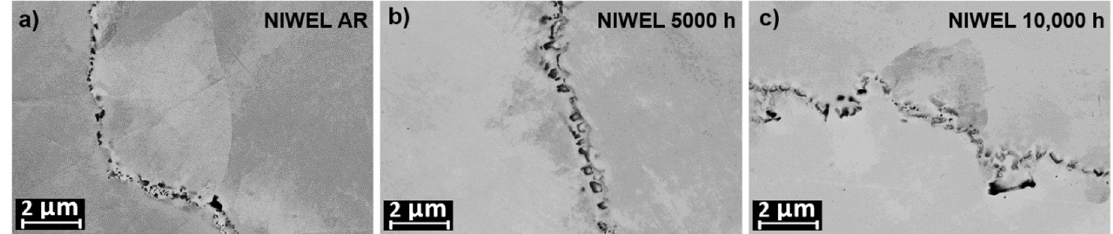
Figure 6. SEM imaging of grain boundaries (GBs) in Alloy 52 weld metal from the NIWEL mock-up before ( a ) and after ageing at 400 °C for 5000 ( b ) and 10,000 h ( c ). No clear signs of GB carbide growth were observed. Table 2. Hardness variation in Alloy 52 weld metal in the NIWEL DMW from the weld crown to the weld root, before and after ageing at 400 °C for 5000 and 10,000 h (SD: standard deviation). . Crown Centre Root NIWEL Mean HV IT